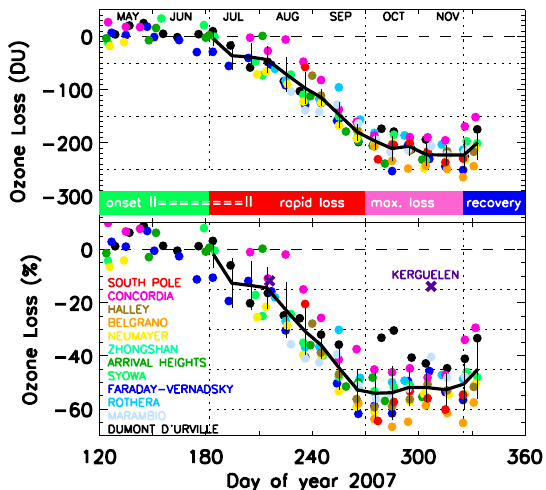
Fig. 5. Vortex averaged (ten-day mean) ozone loss diagnosed using different measurements and various tracer calculations by differ- ent model setups at Dumont d’Urville (top: DU, bottom: percent). The loss in absolute unit (DU) is estimated as ozone meas -tracer and its relative loss (%) is computed as 100 × (ozone meas -tracer)/tracer. The black solid lines represent the mean ozone loss from all sce- narios and the black filled-circles represent the average deviation from the control (SAOZ/REPROBUS tracer). The error bars rep- resent the standard deviation from the mean. The dotted vertical line represents 1 July. The dotted horizontal lines represent 100 and 200DU and 20 and 40% of ozone